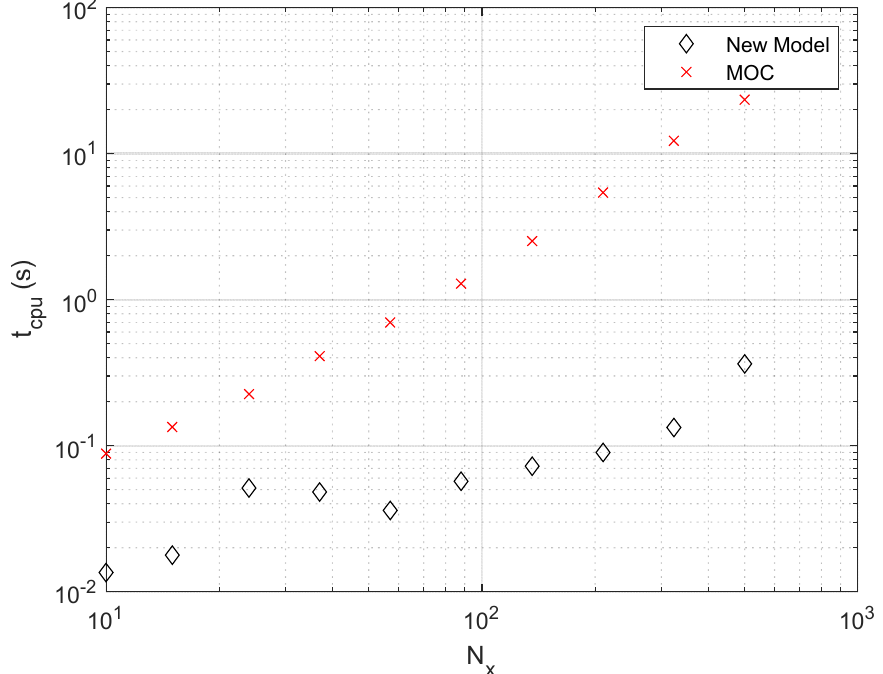
Figure 11. Computation time required to calculate a sample solution, as the time resolution is varied. For the MOC case, N x corresponds to the number of spatial grid points. For the frequency-domain case, the frequency points were selected to give the same time resolution as the MOC case.